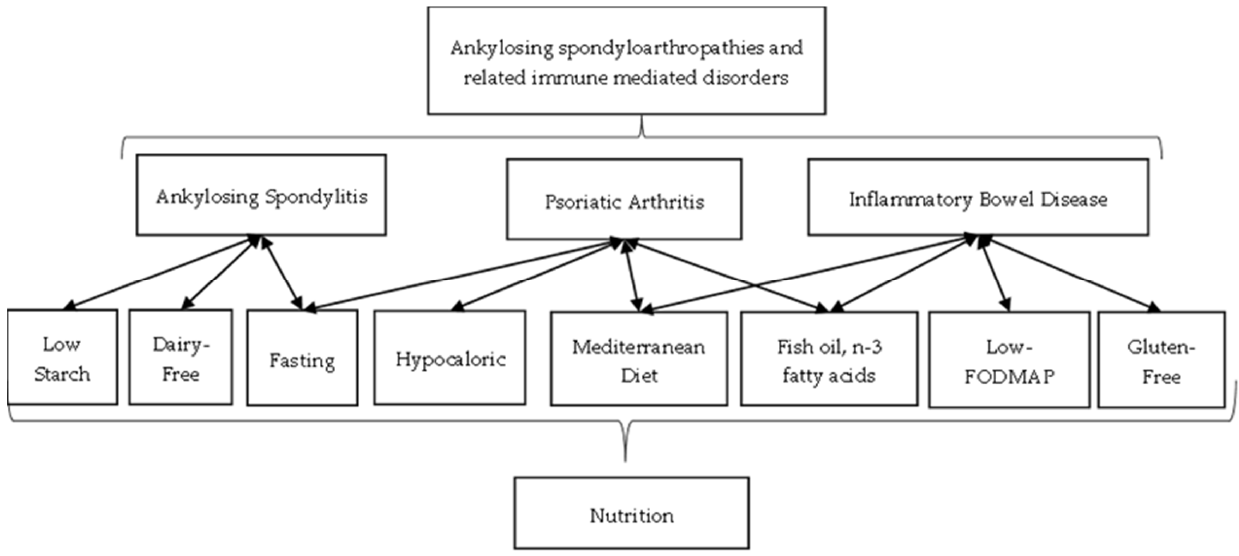
Figure 1. Nutrition in ankylosing spondyloarthropathies and related immune-mediated disorders.